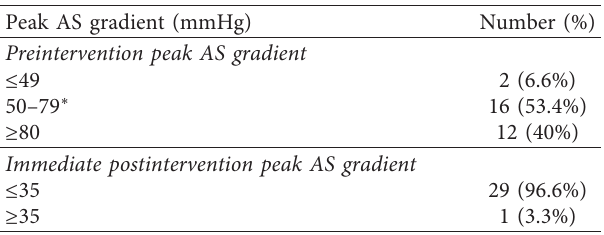
Table 2: Summary of the distribution of preintervention and postintervention peak systolic gradient (PSG) measured during cardiac catheterization.